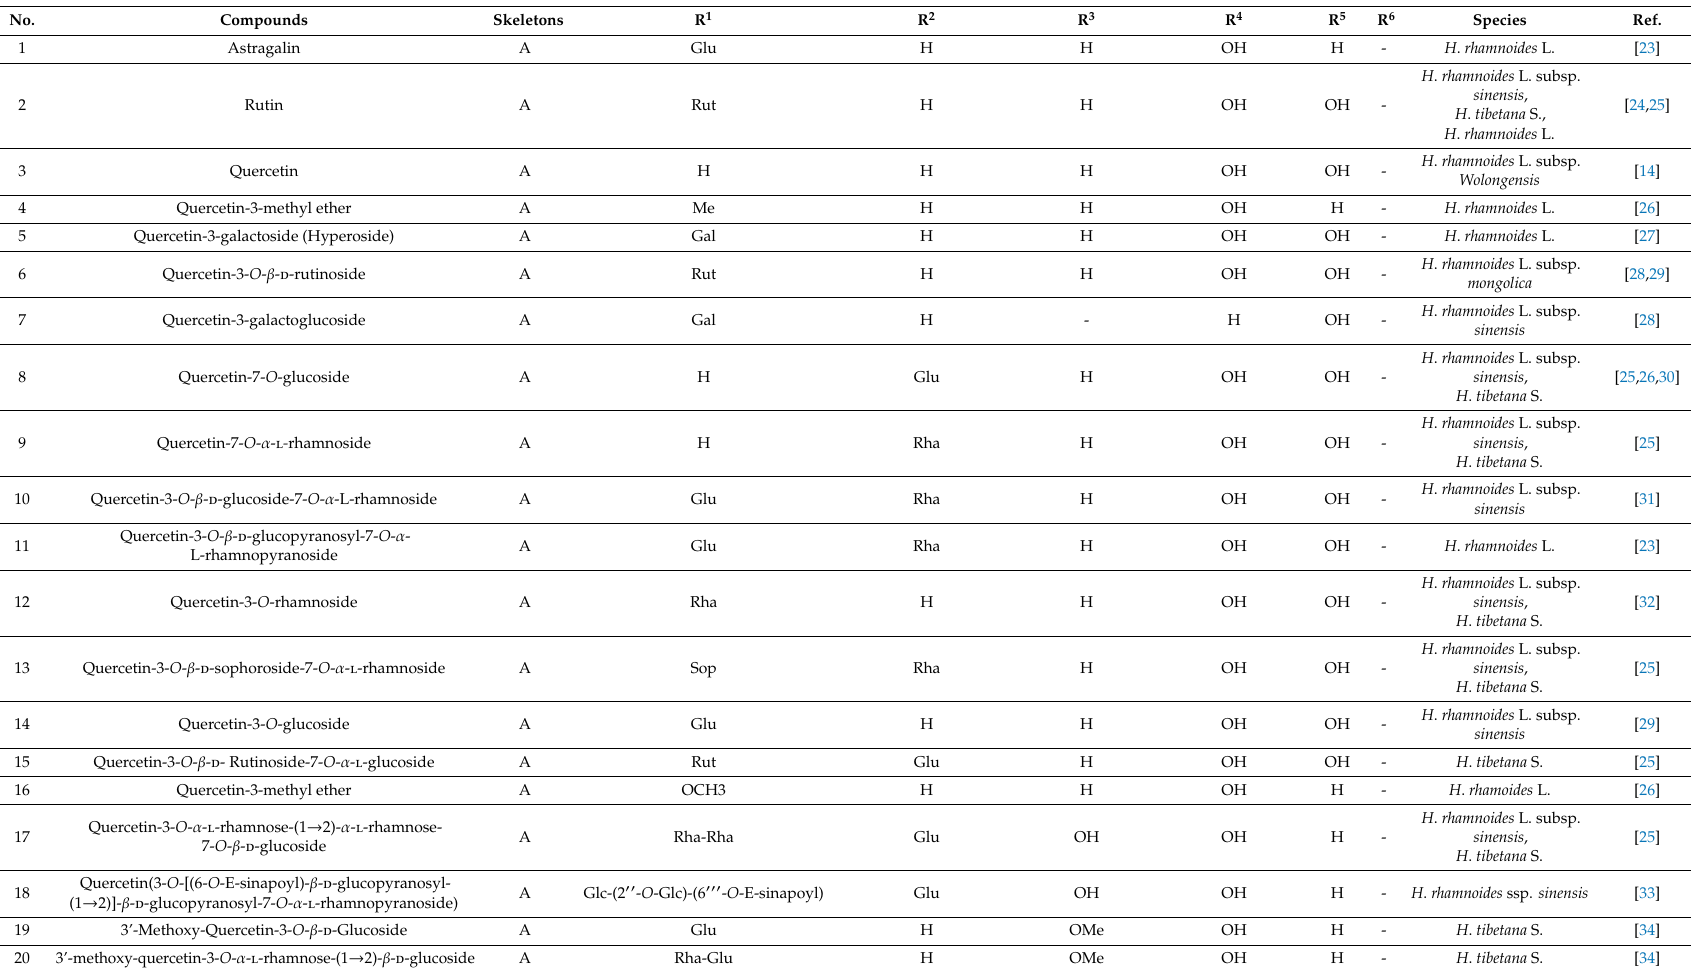
Table 1. Flavonoids from Hippophae